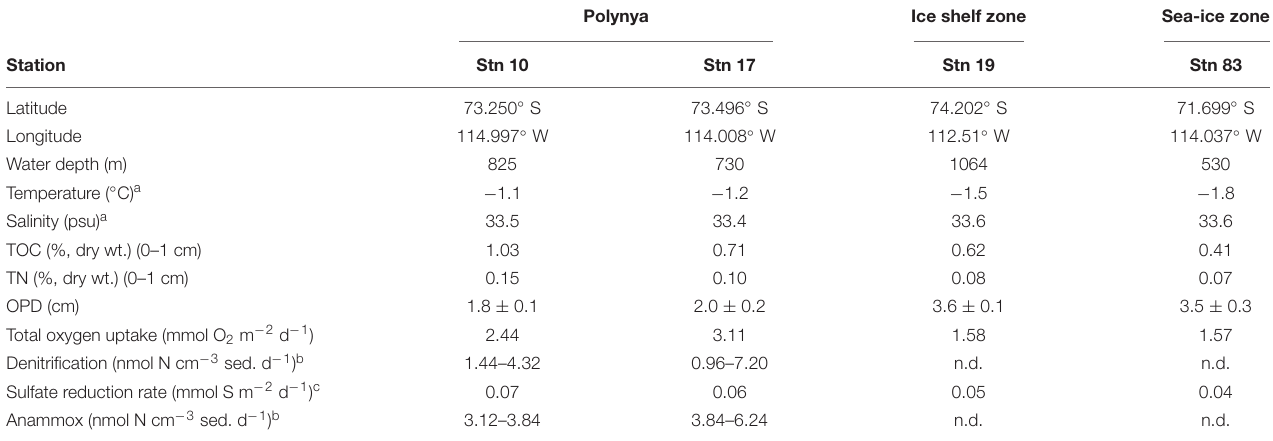
TABLE 1 | Oceanographic parameters and sediment properties, February 18–March 07,